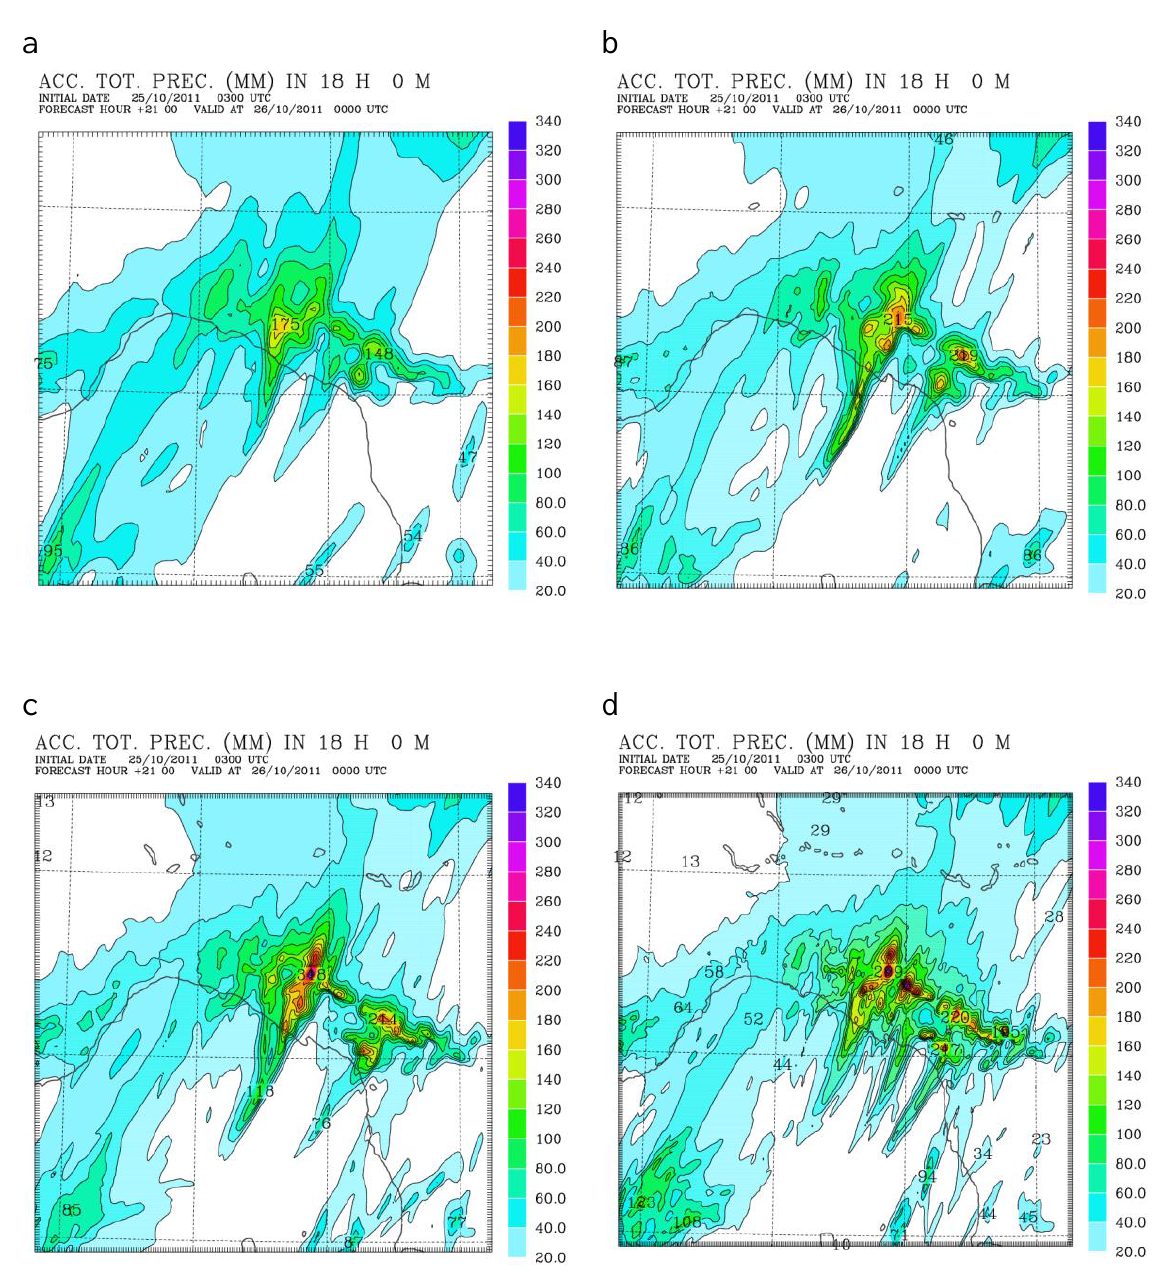
Figure 7. Precipitation accumulated in the 18h period starting at 06:00UTC of 25 October 2011 in MOLOCH forecast runs, based on NOAA-GFS analysis at 00:00UTC of the same day, for different grid mesh sizes: 3.0km, max. 175mm (a) , 2.0km, 215mm (b) , 1.5km, 318mm (c) , 1.0km, 299mm (d) . Contour interval: 20 mm.